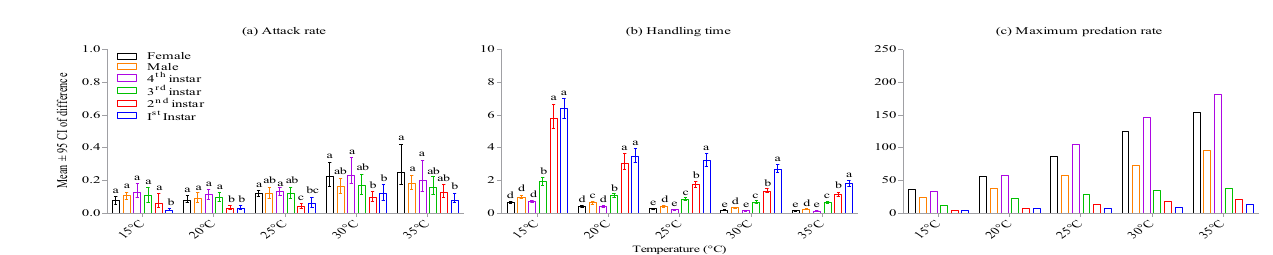
Figure 7. Functional response parameters of Harmonia axyridis preying on Acyrthosiphon pisum nymphs under different thermal conditions, resulting from bootstrapped functional response parameters. Different letters above the bars within each temperature indicate significant difference ( P < 0.05) among growth stages of the predator based upon non-overlapping 95% CI of